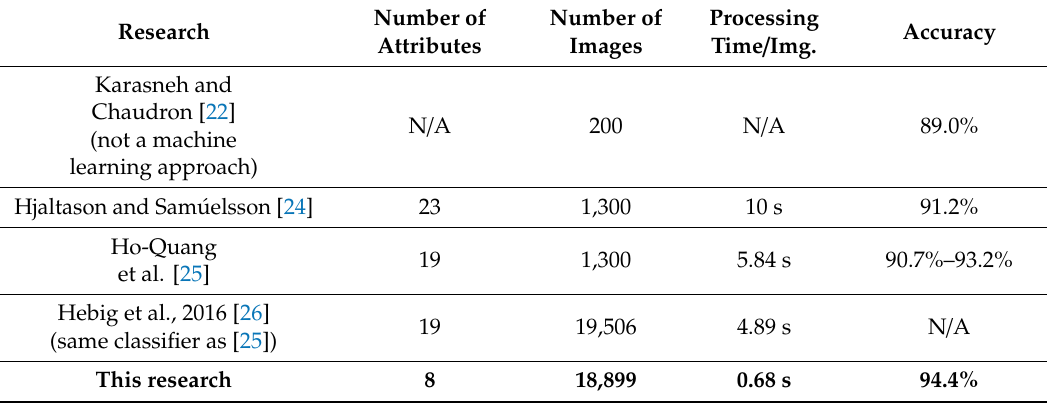
Table 5. Comparison of the results of our method with those of related